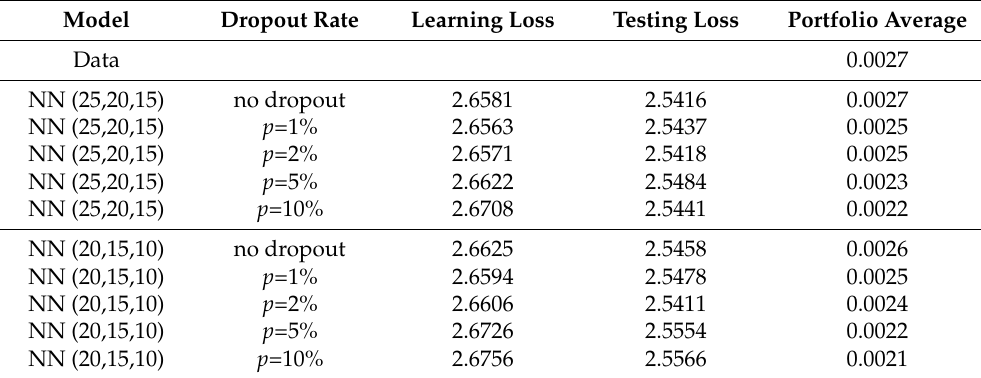
Table 7. Testing loss and learning loss of the Poisson neural network models ((20,15,10) and (25,20,15) architecture) with dropout rates of 0%,1%,2%,5% and, 10%.